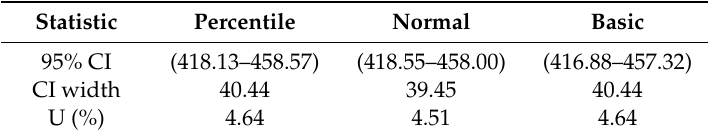
Table 4. Comparison of the confidence interval computation methods.